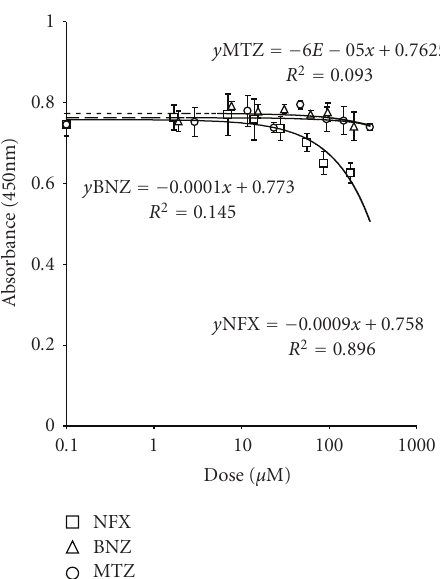
Figure 1: Cytotoxic e ff ects induced in immortalized lymphocytes when detected by MTS assay (48 hours treatment).